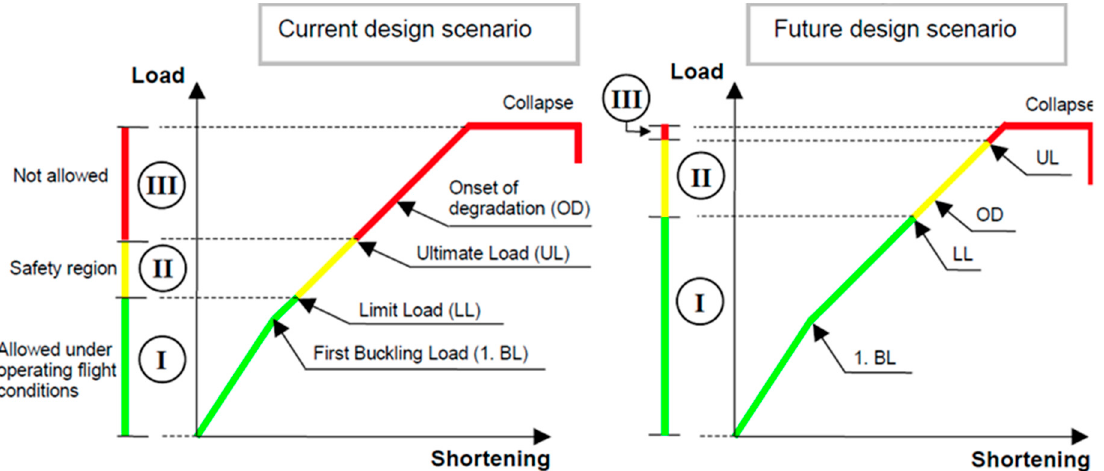
Figure 2. Current and possible future design scenarios for typical stringer-stiffened composite panels; opening of flight conditions towards unexploited potential of post-buckling and contained damage (drawn from